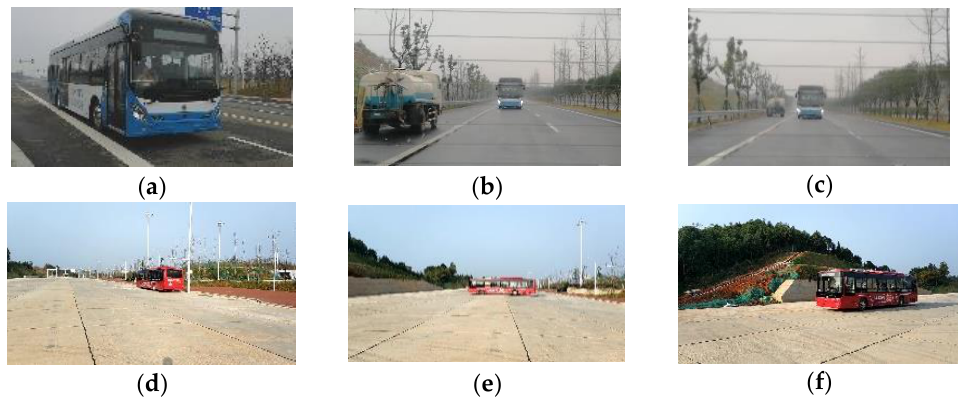
Figure 19. Real bus experiments. ( a ) Overview of the driverless bus. ( b , c ) Lane-keeping. ( d – f ) U-turn.